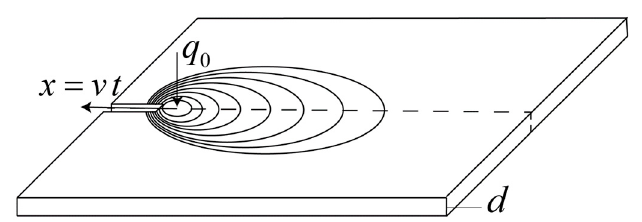
Figure 2. Outline of the analytical 2D heat flow model for HYB butt welding.